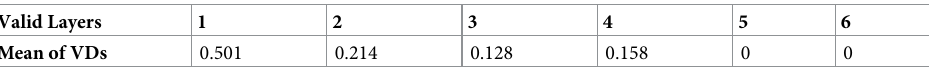
Table 2. Mean of VDs driven by high KE nodes in different valid layers. Valid